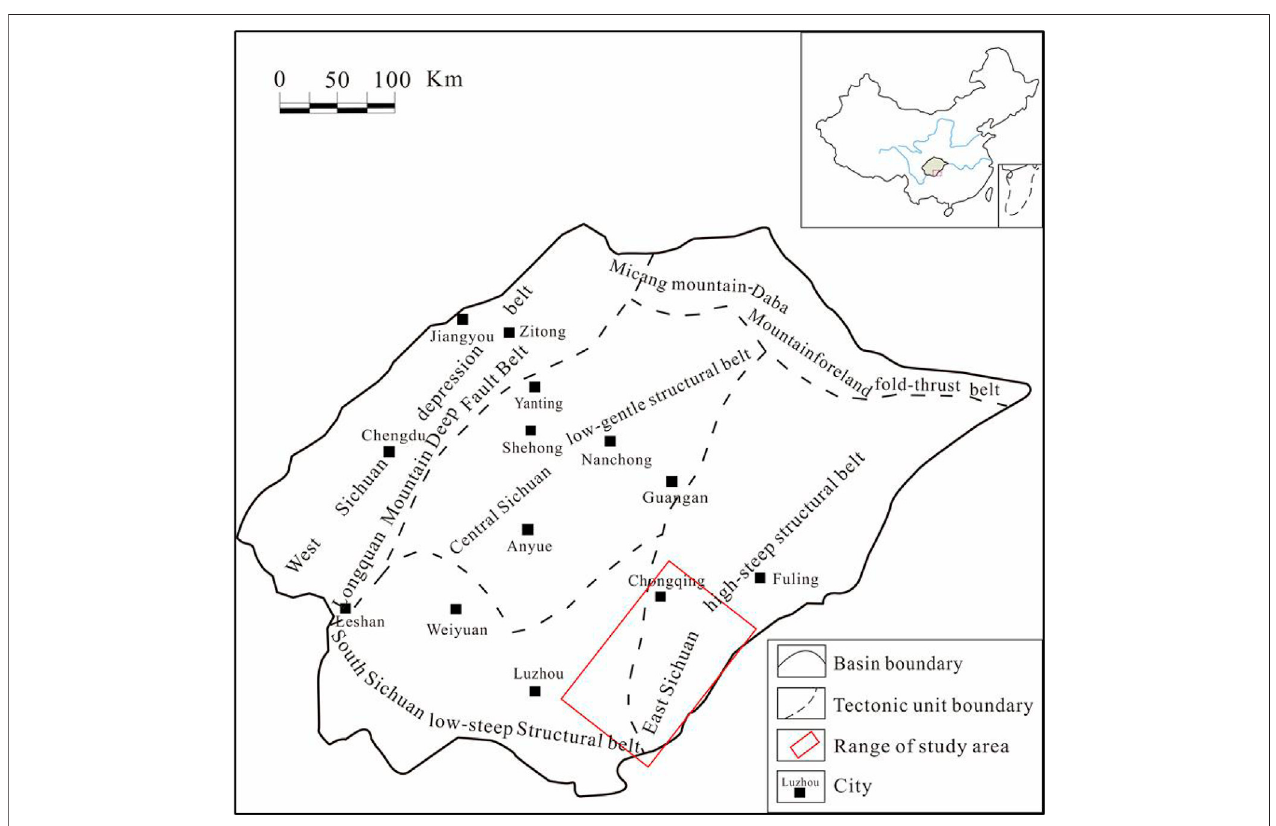
FIGURE 1 | Schematic map of geology of southeast Sichuan (modi fi ed from Liu et al., 2019)